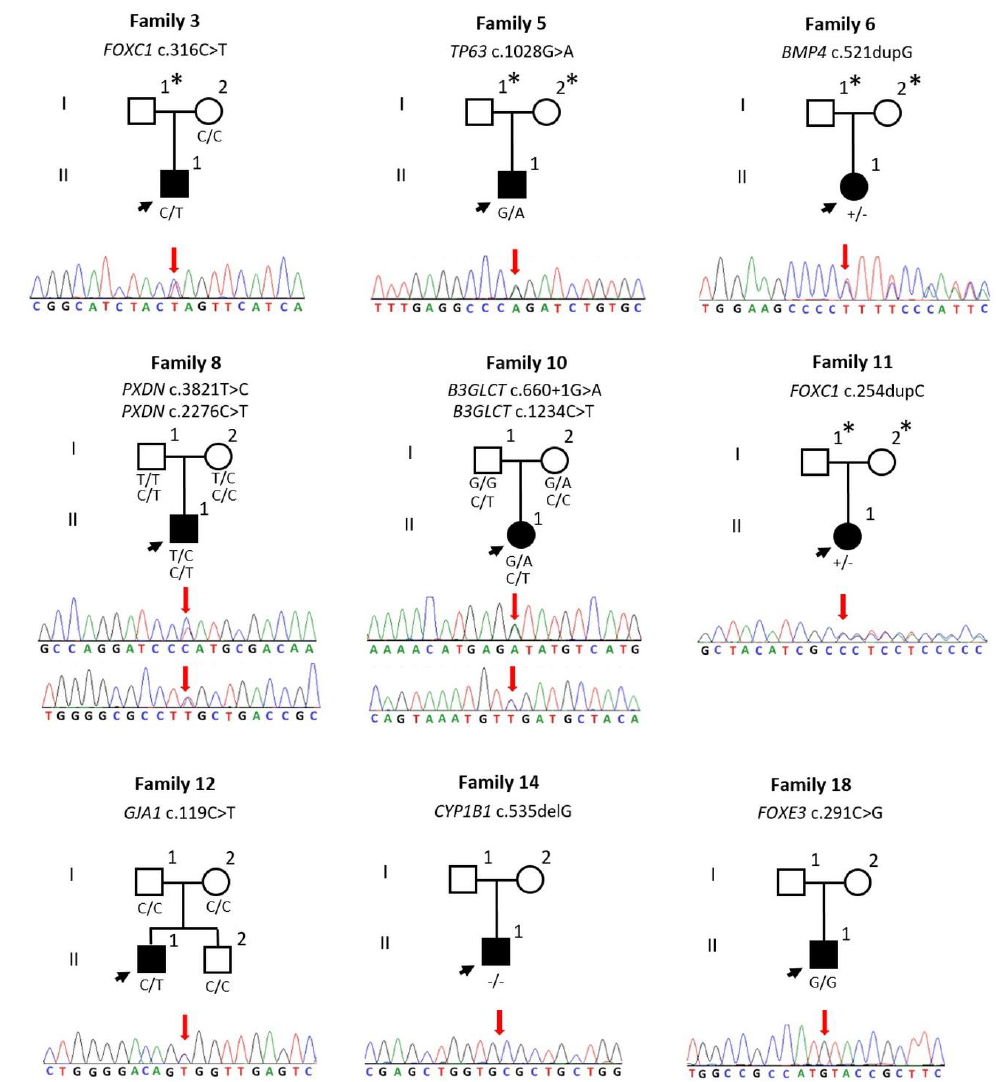
Figure 1. Pedigrees of the studied families, electropherograms, and segregation of the variants. Sanger sequencing traces represents identified variant positions (red arrow). * These individuals were not phenotypically evaluated therefore expected dominant transmission or de novo occurrence could not be demonstrated.